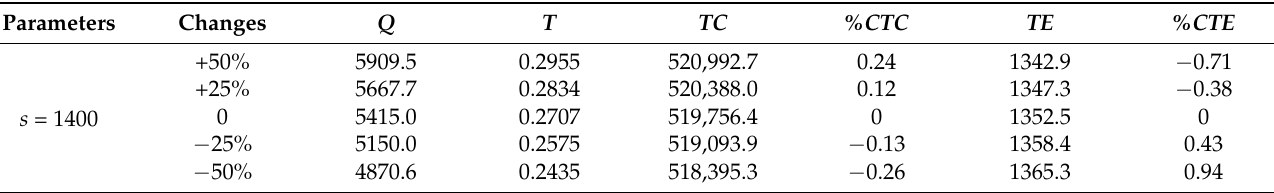
Table 4. Effects of changes in cost parameter